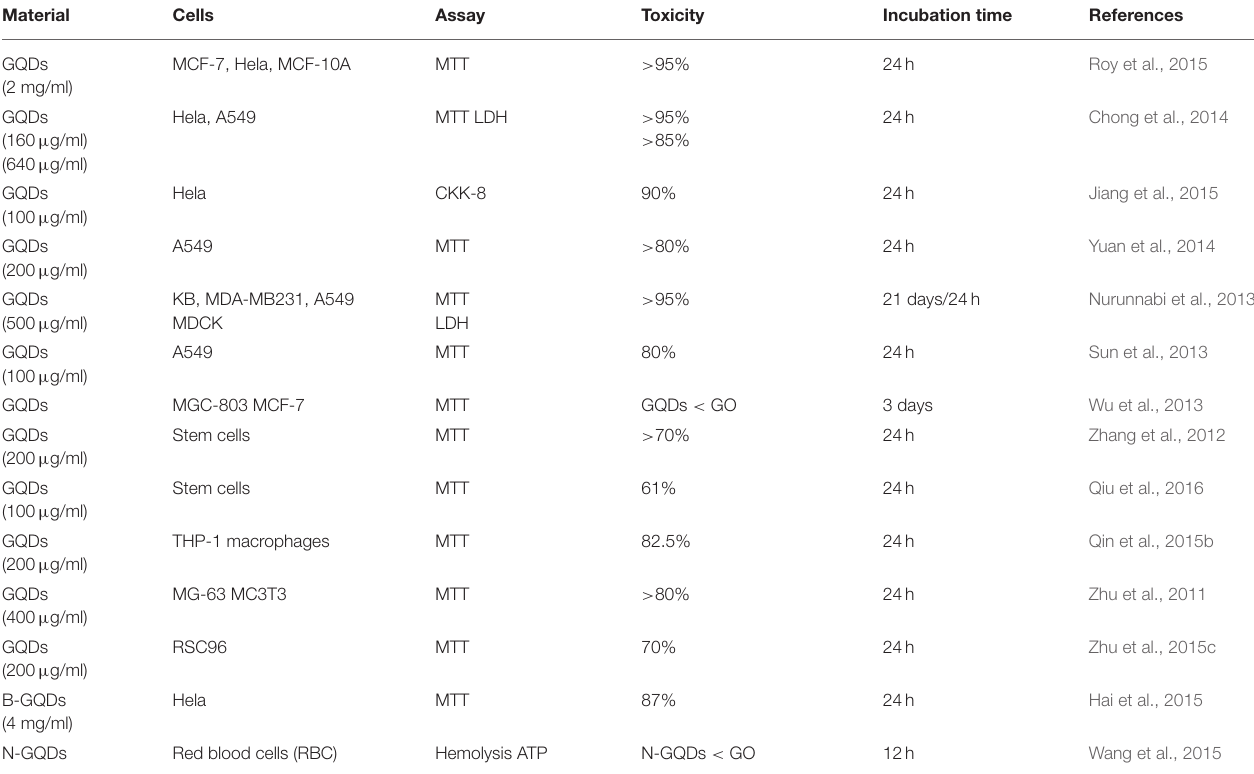
TABLE 1 | Toxicity of graphene quantum dots (GQDs) and doped-GQDs.